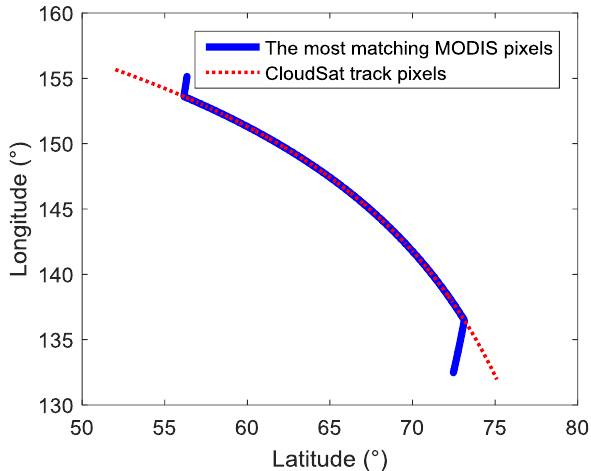
Figure 8. Most matching MODIS pixels on the track and the truncated Cloud Profiling Radar (CPR) track for the granule shown in Figure 7 using Equation (1).